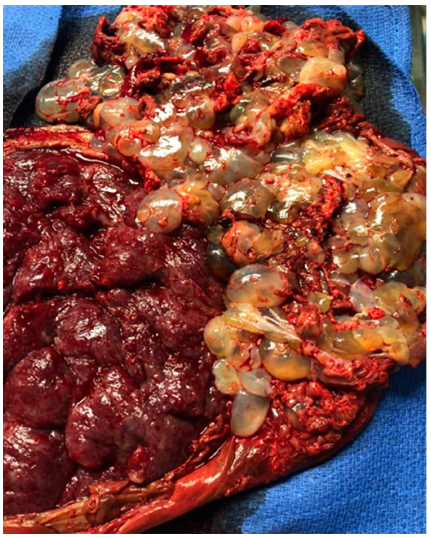
Figure 3: Placenta of normal pregnancy adjacent to complete molar pregnancy at